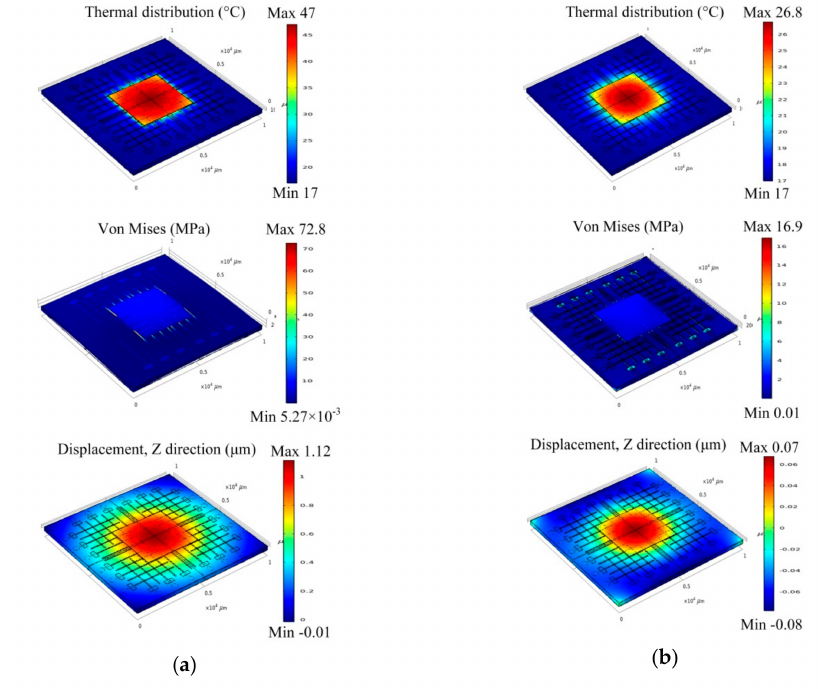
Figure 10. The thermal distribution, von Mises stress and warpage of the interposers with ( a ) PI dielectric and ( b ) the proposed composite